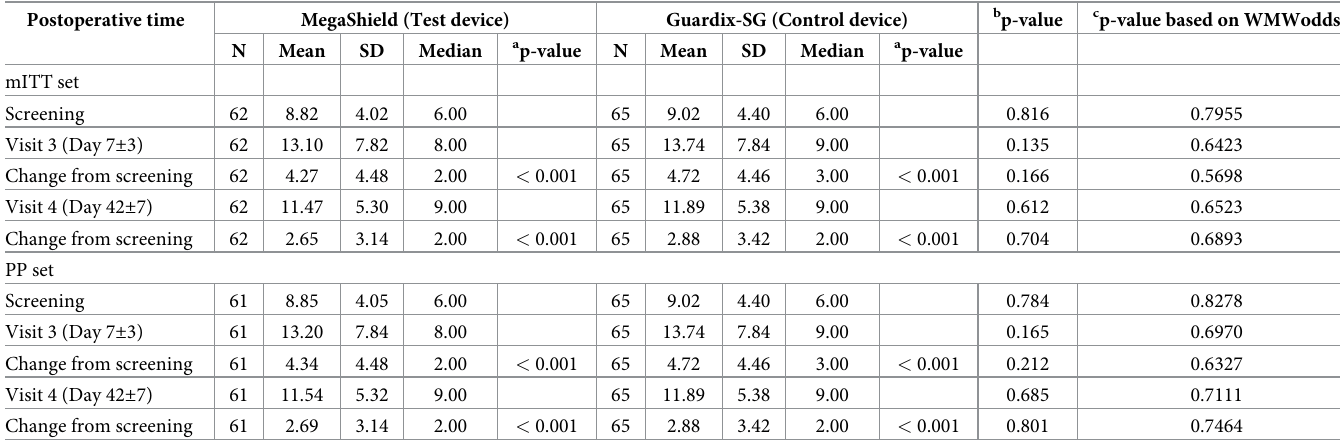
Table 5. Summary of total adhesion scores by postoperative time. Postoperative time